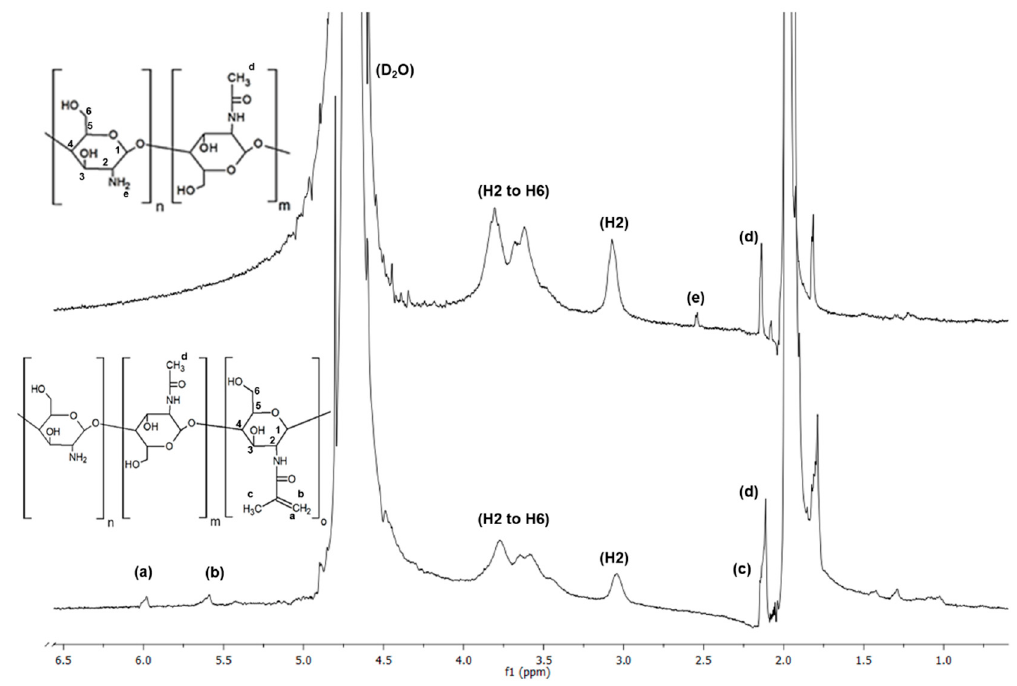
Figure 2. NMR spectra of the original and functionalized chitosan (ChMA).